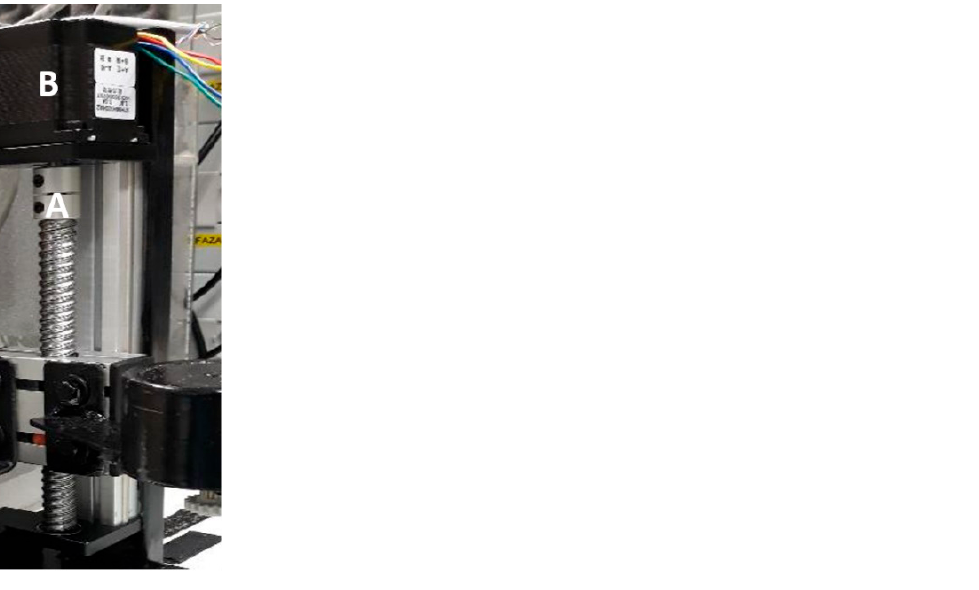
Figure 4. View of the distance adjustment circuit d (lens-observed component); A—worm gear; B—stepper motor to adjust the distance between the lens and the observed element.